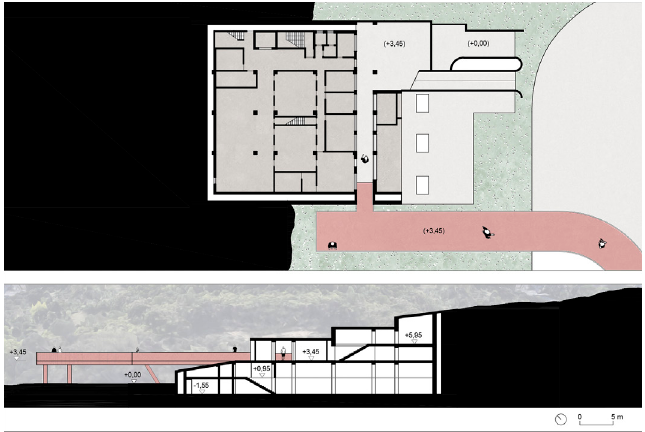
Fig. 5 Belardi, P., Battistoni, M., &